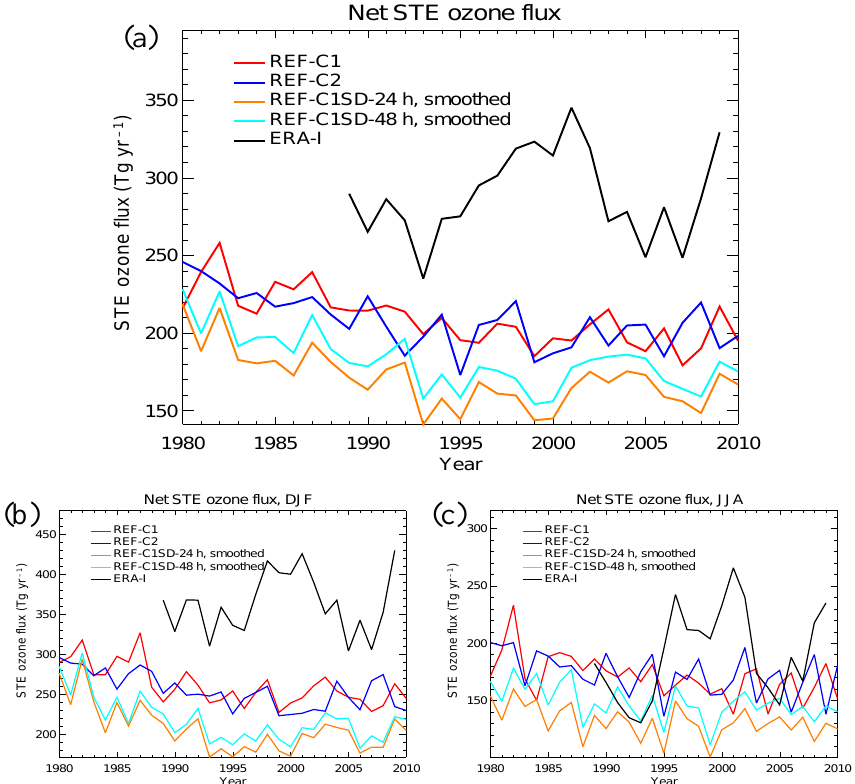
Figure 13. Stratosphere–troposphere exchange of ozone for (a) annual mean, (b) December–January–February, and (c) June–July–August. This flux of ozone across the tropopause is calculated using monthly mean residual vertical velocity and ozone mass mixing ratio, following Hegglin and Shepherd (2009). The tropopause is here defined as the 100hPa surface equatorward of 50 ◦ and the 200hPa surface poleward of 50 ◦